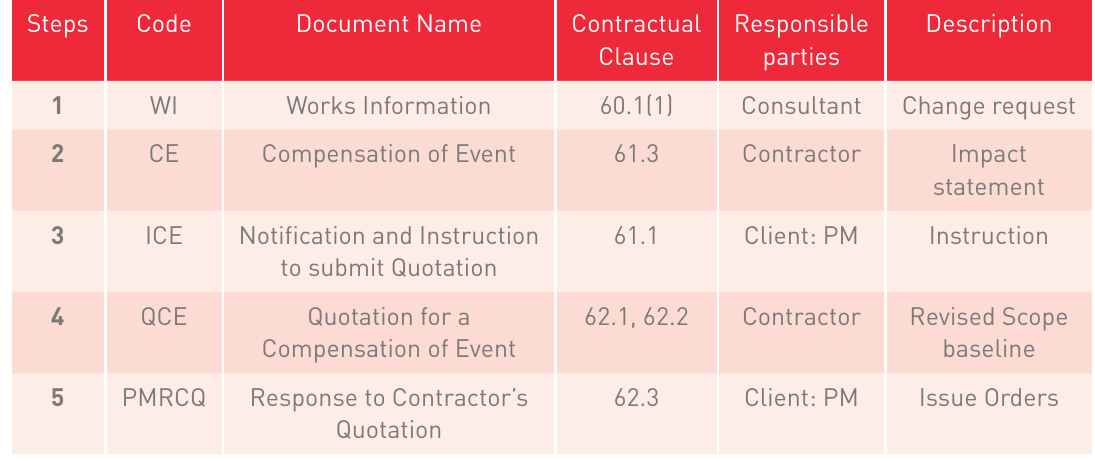
Table 2. NEC change control system for construction works